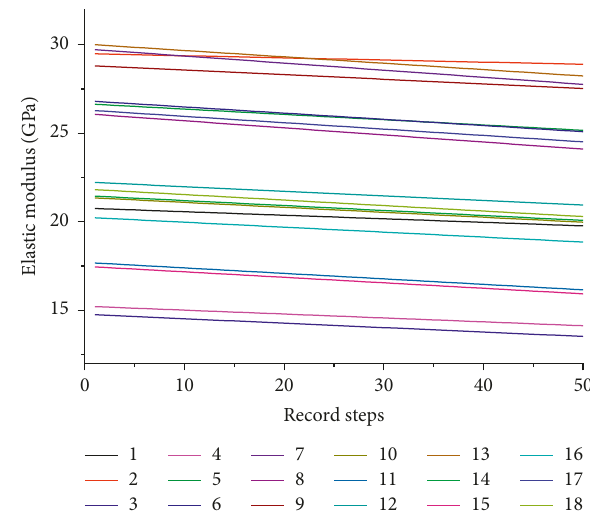
Figure 9: Deterioration of elastic modulus with damage evolution.